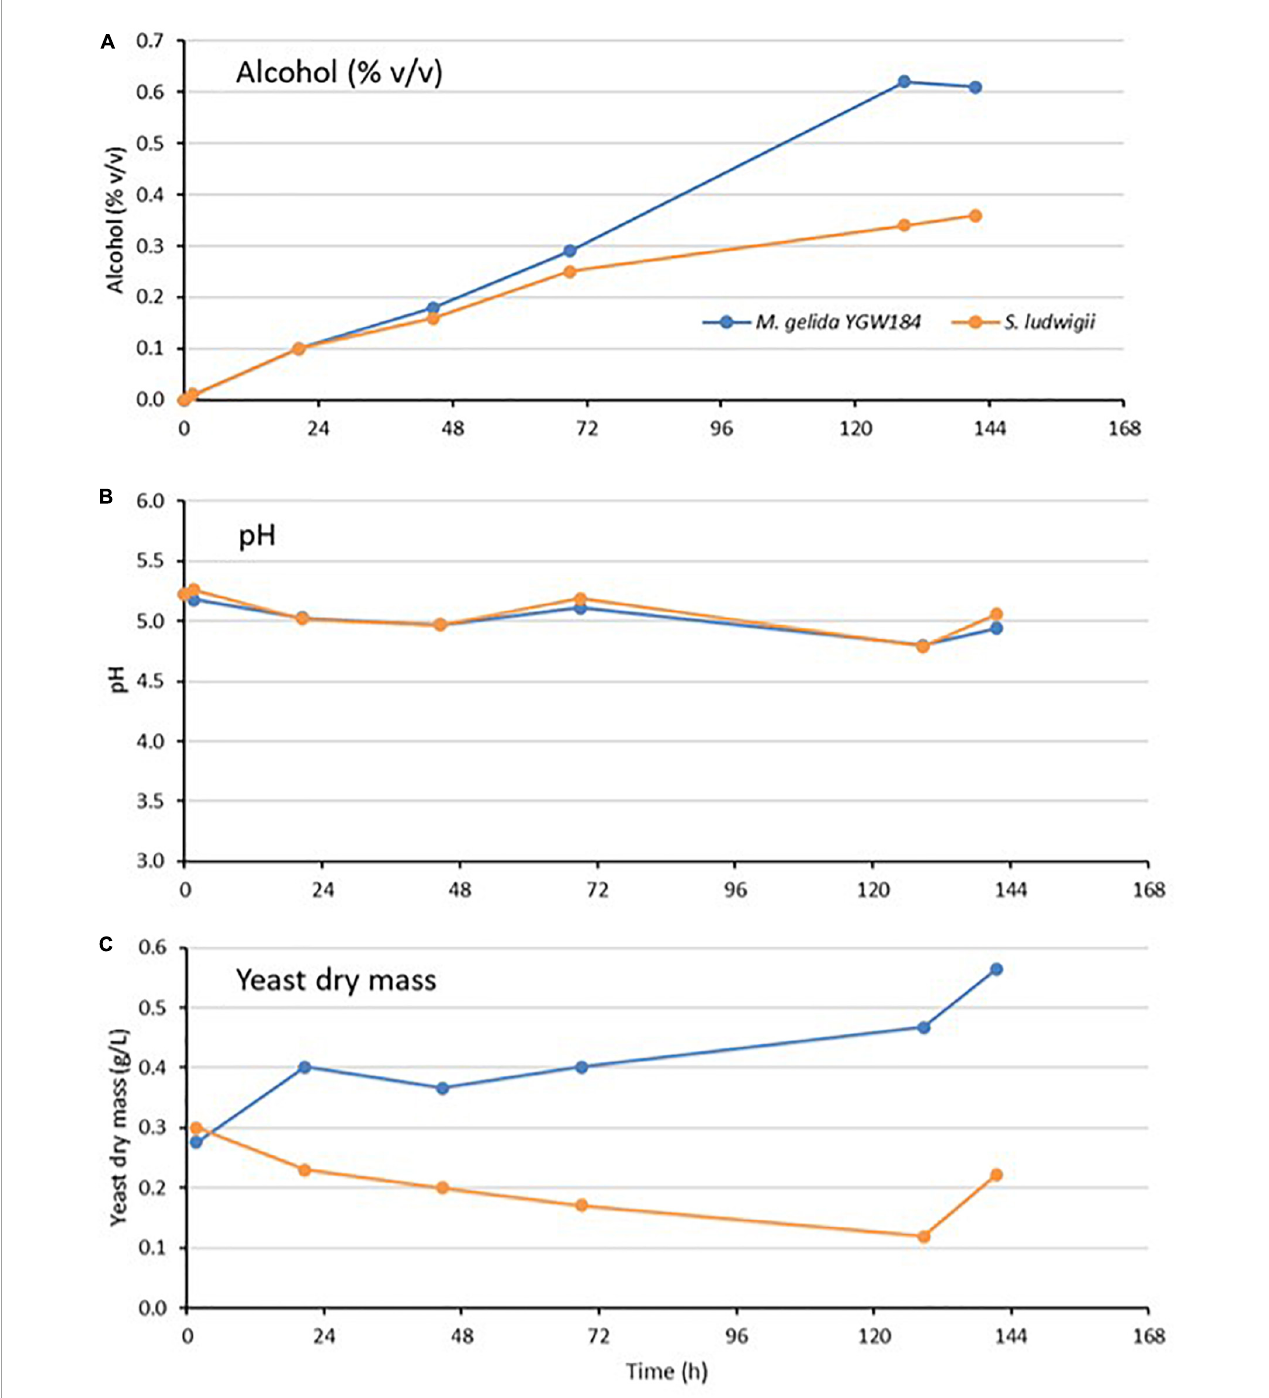
FIGURE2 Fermentation of 7.5 ◦ P wort at 10 ◦ C by Mrakia gelida YGW184 and Saccharomycodes ludwigii measured by alcohol formation (A) , change in wort pH during fermentation (B) , and change in yeast dry mass in suspension during the fermentation (C)